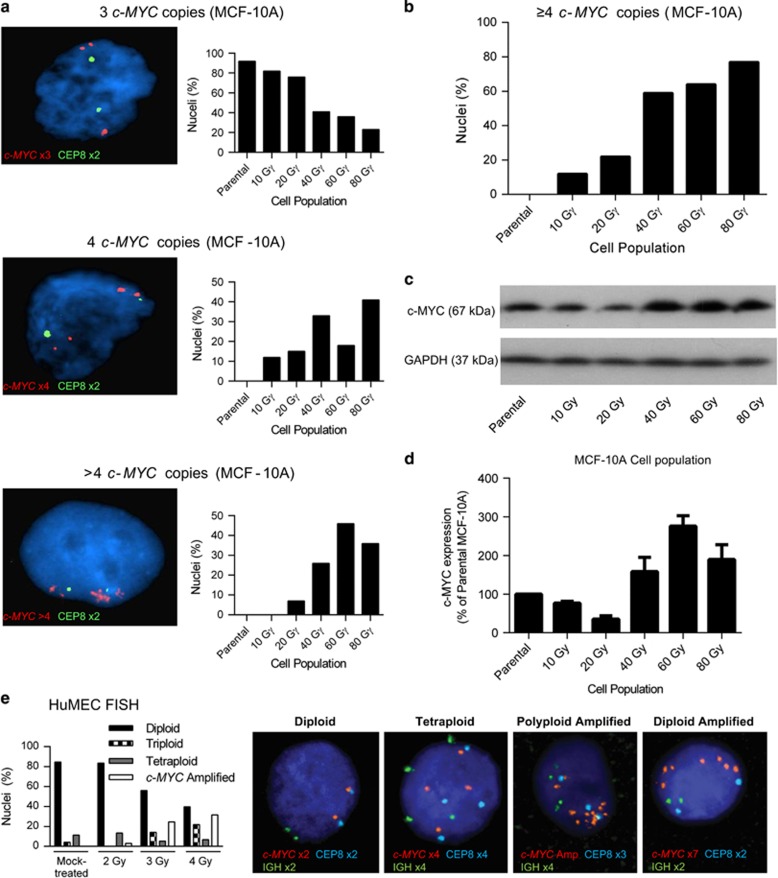
Genotypic and phenotypic alterations of c-MYC in irradiated huMECs and MCF-10A cells. c-MYC interphase FISH copy number analysis of parental and irradiated MCF-10A populations. Three main cell populations were identified by FISH: cells with two copies of chromosome 8 centromere (green probe) and three copies of c-MYC (red probe), cells with two copies of chromosome 8 and four copies of c-MYC and cells with two copies of chromosome 8 and over four copies of c-MYC (a). The proportion of 100 scored nuclei with these three c-MYC genotypes was combined and determined for each population. The proportion of nuclei with ⩾4 copies of c-MYC and therefore any cell population with a c-MYC copy number gain was determined (b). Aliquots of 10 μg of protein extracted from parental and irradiated MCF-10A cell populations were electrophoresed on polyacrylamide gels and analysed for c-MYC and glyceraldehyde 3-phosphate dehydrogenase (GAPDH) expression by western transfer analysis as described in the Materials and methods (c). c-MYC expression was quantified for each cell population by densitometric analysis of western blots from three independent protein samples (d). c-MYC expression is expressed as a percentage of c-MYC expression in parental MCF-10A, which is set at 100% expression. Expression of c-MYC was significantly higher in the 60 Gy population than parental MCF-10A (Turkey's test; P<0.05). c-MYC interphase FISH copy number analysis of parental and irradiated HuMECs (e). Four main cell populations were identified by FISH: diploid cells (two copies of chromosome 8 centromere (aqua probe), two copies of IGH (green probe) and two copies of c-MYC (red probe)); triploid cells (three copies of each locus); tetraploid cells (four copies of each locus); cells with amplification of c-MYC. At least 70 interphase cells were counted at each radiation dose (mock-treated, 2, 3 and 4 Gy) and example images are shown for diploid, tetraploid and c-MYC-amplified cells.